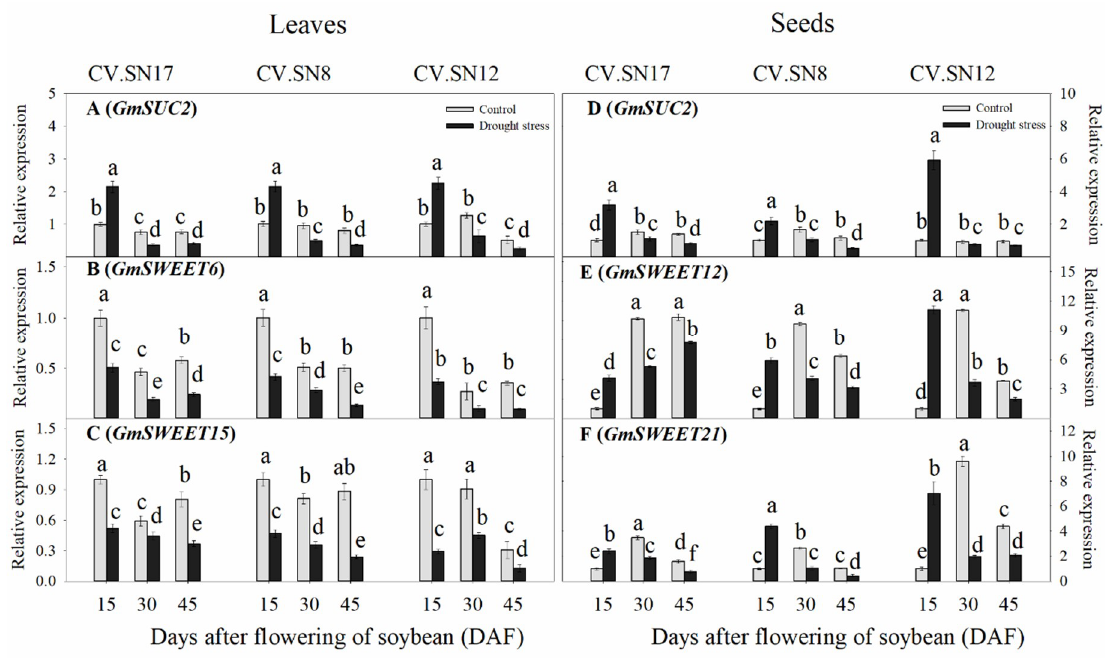
Figure 3. Effect of drought stress on the expression levels of sucrose transporter genes in leaves and seeds. ( A – C ) The expression levels of GmSUC2 , GmSWEET6 , and GmSWEET15 in leaves. ( D – F ) The expression levels of GmSUC2 , GmSWEET12 , and GmSWEET21 in seeds. Standard deviations were calculated with three independent experiments each comprising two soybean plants. Different letters above vertical bars indicate significant differences between means at a p < 0.05 level.